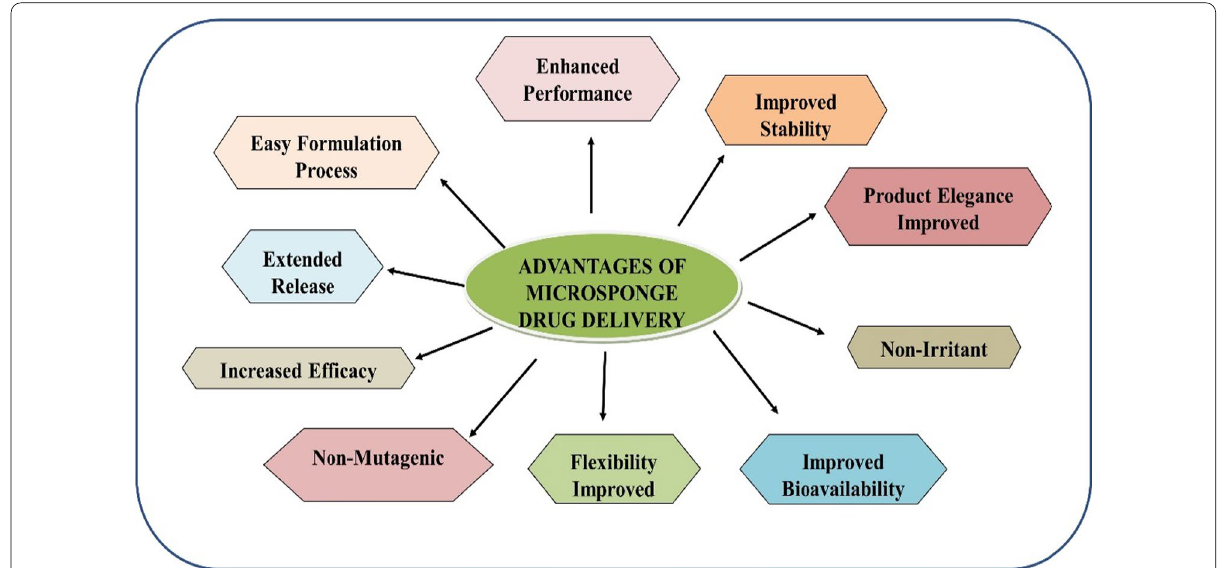
Fig. 2 Merits of drug delivery through microsponge